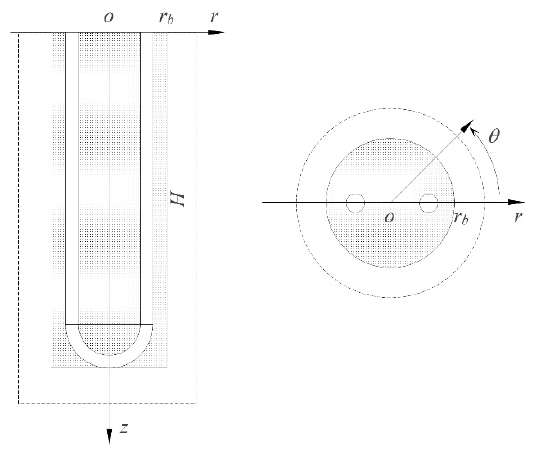
Figure 1. Layout of a typical U-tube configuration.